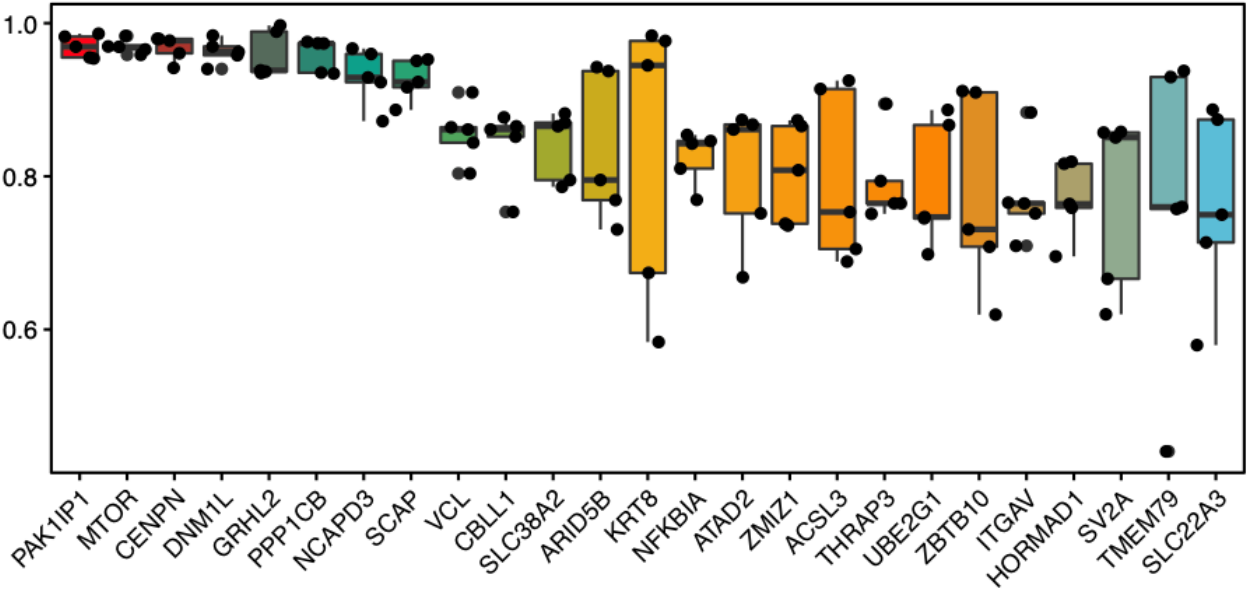
Figure 1. Essential and AR-upregulated genes in androgen-sensitive and PSA-positive LNCaP cell line. Data taken from 5 LNCaP genome-wide CRISPR screens in DepMap database (DepMap 21Q4, DepMap 21Q3, GeCKO 19Q1, GeCKO CERES, Sanger CERES) and ranked based on their essentiality. AR-upregulated genes are taken from RNA-seq samples of androgen-treated LNCaP cells (GEO: GSE64529).